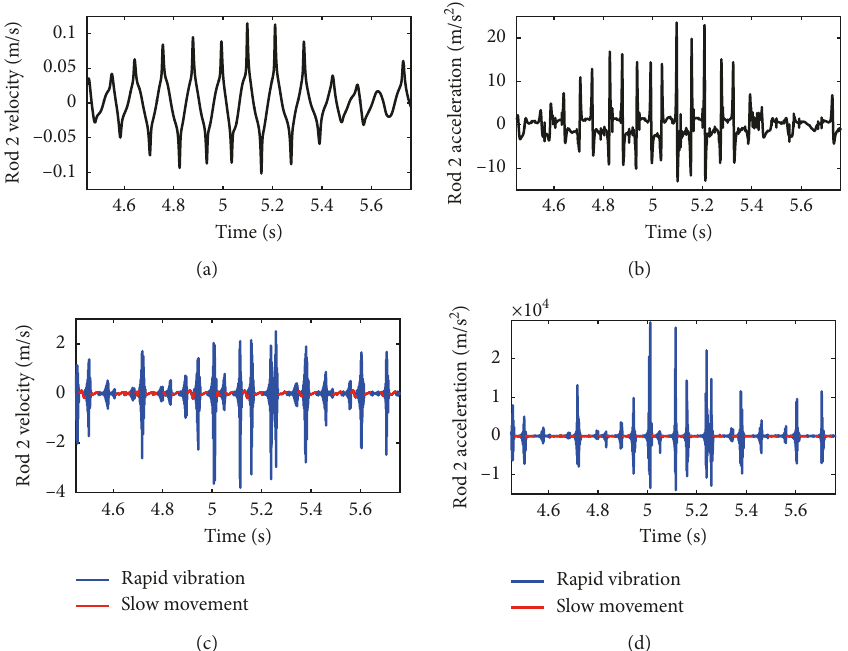
Figure 8: Movement of rod 2: velocity and acceleration in the ideal model (a, b) and clearance model (c, d) ( c � 0.5mm, 4.5 s < t < 5.75 s).